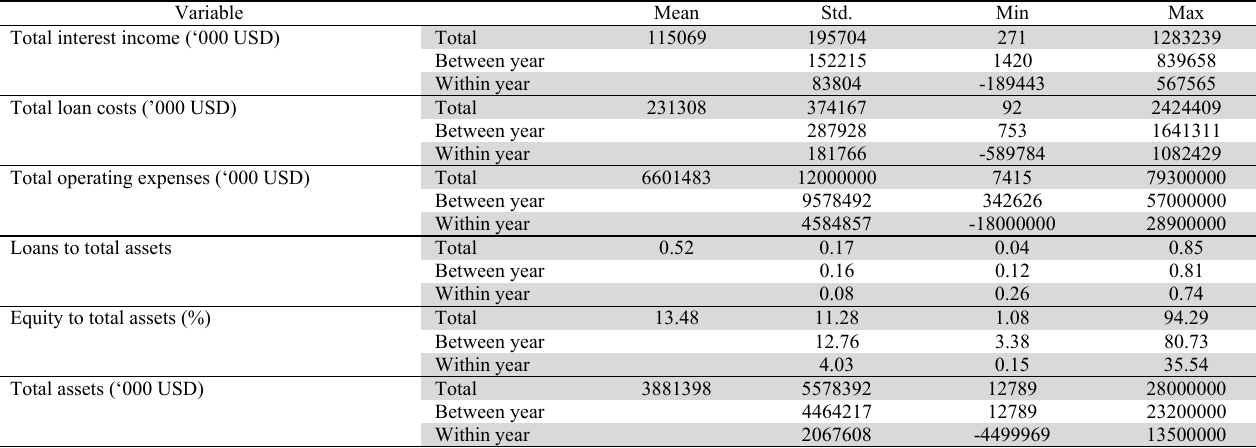
Statistical description (model 3.1),